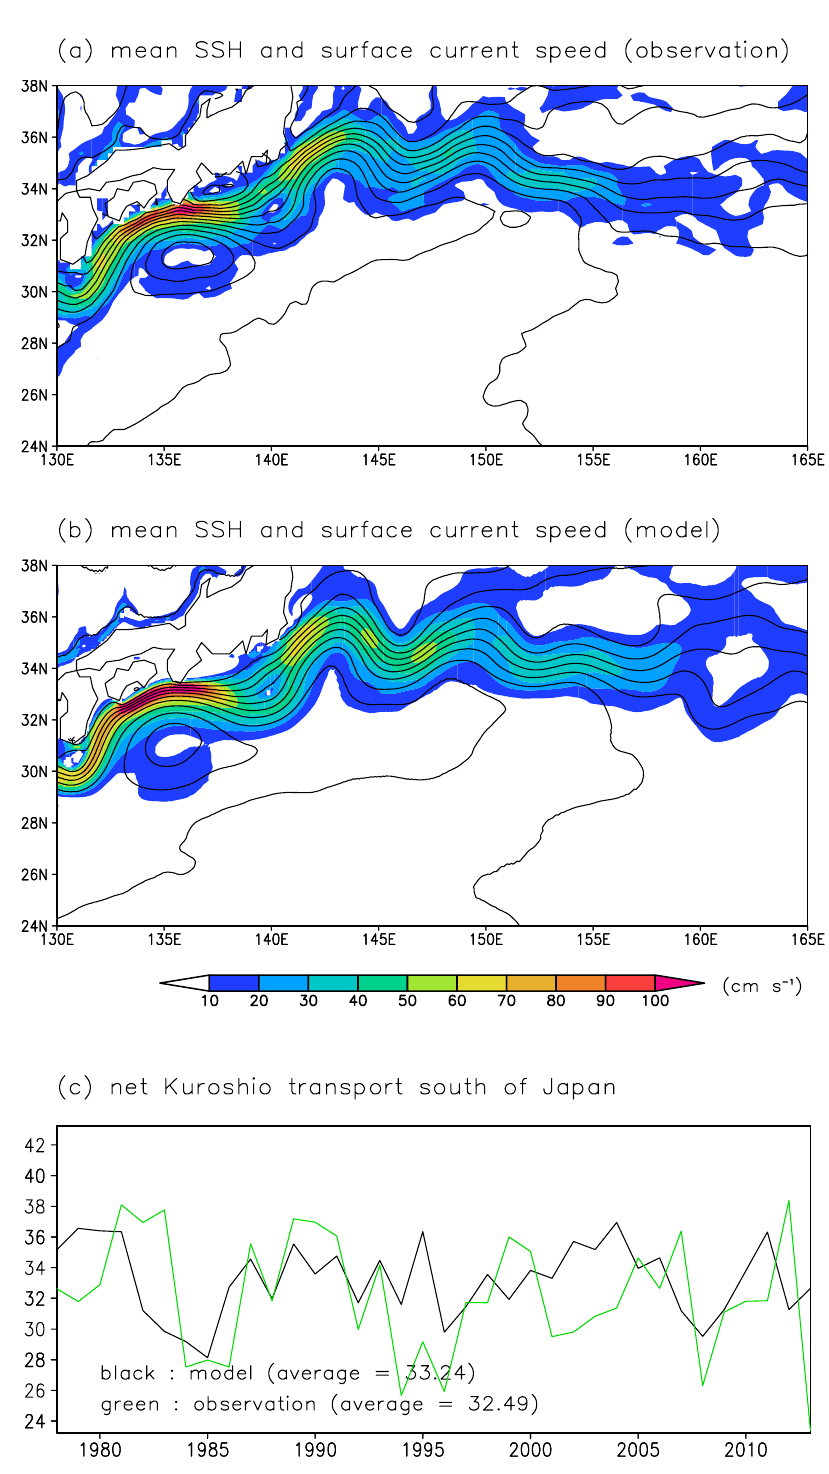
Figure 2. Reproducibility of the Kuroshio and the KE in the NP model. SSH (cm) (contour, 10-cm intervals) and surface current speed (cm s –1 ) (shading) from ( a ) satellite measurements and ( b ) the CTRL run averaged over 1993–2013. ( c ) Net Kuroshio transport (Sv; 1 Sv = 10 6 m 3 s –1 ) across 137°E from hydrographic observations by the Japan Meteorological Agency (green) and the CTRL run